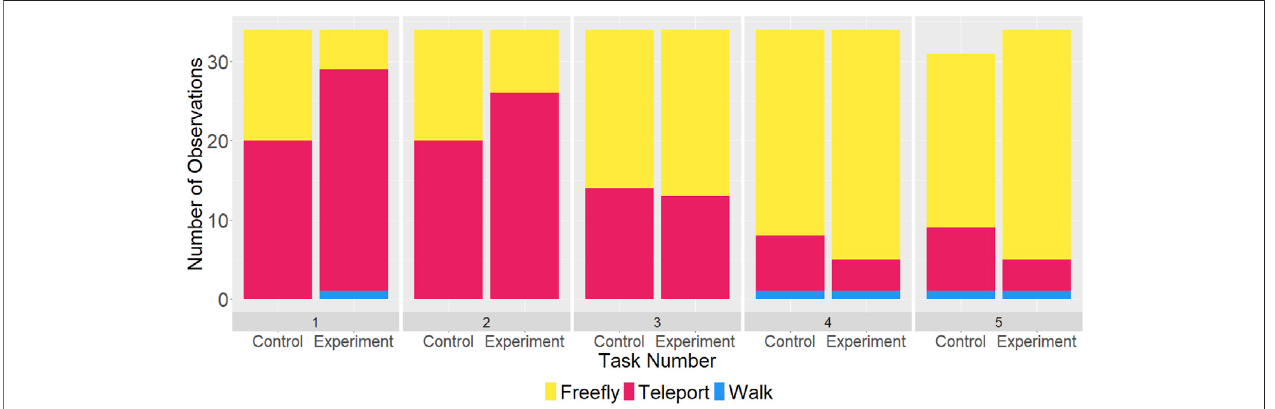
FIGURE 12 | Navigation methods selected by subjects at task submission during VR Trial 2. Three outliers for the control cohort were removed for Task 5.